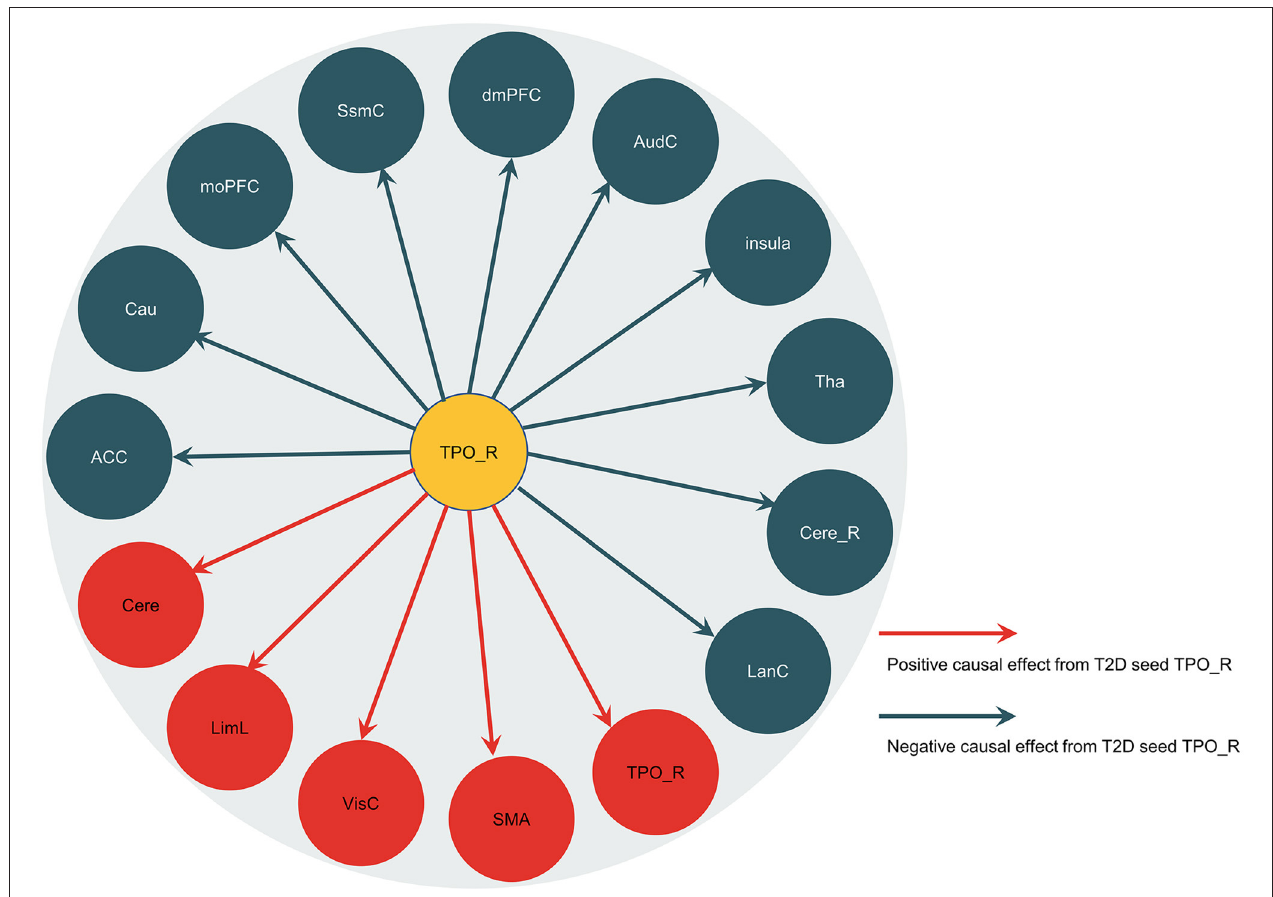
FIGURE 3 | Summary of the right temporal pole-based CaSCN analysis results. The arrow lines represent the positive causal effects or the negative causal effects from the seed region (the right temporal pole). TPO_R, the right temporal pole; LimL, limbic lobe; VisC, visual cortex; SMA, supplementary motor area; LanC, language cortex; Cere_R, right cerebellum; Tha, thalamus; AudC, auditory cortex; dmPFC, dorsal medial prefrontal cortex; SsmC, sensorimotor cortex; moPFC, medial orbital prefrontal cortex; Cau, caudate; ACC, anterior cingulate cortex; Cere, bilateral